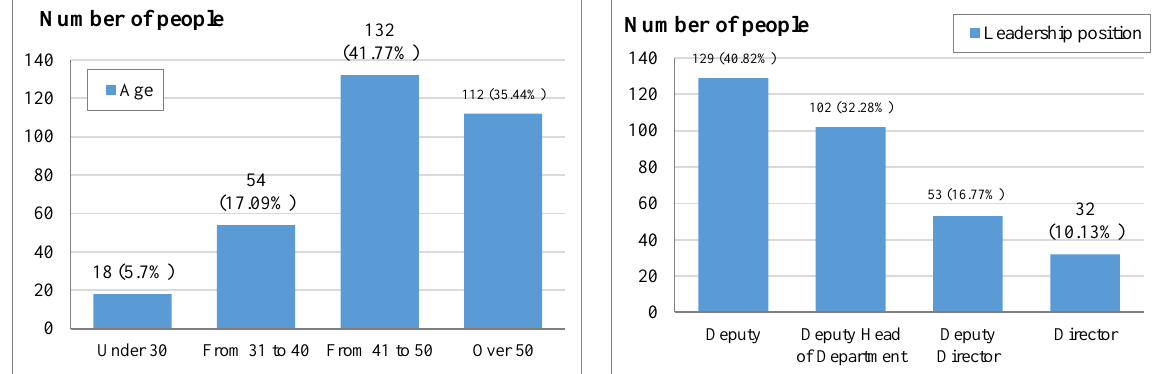
Figure 3. Descriptive statistics of the sample by age and leadership position.